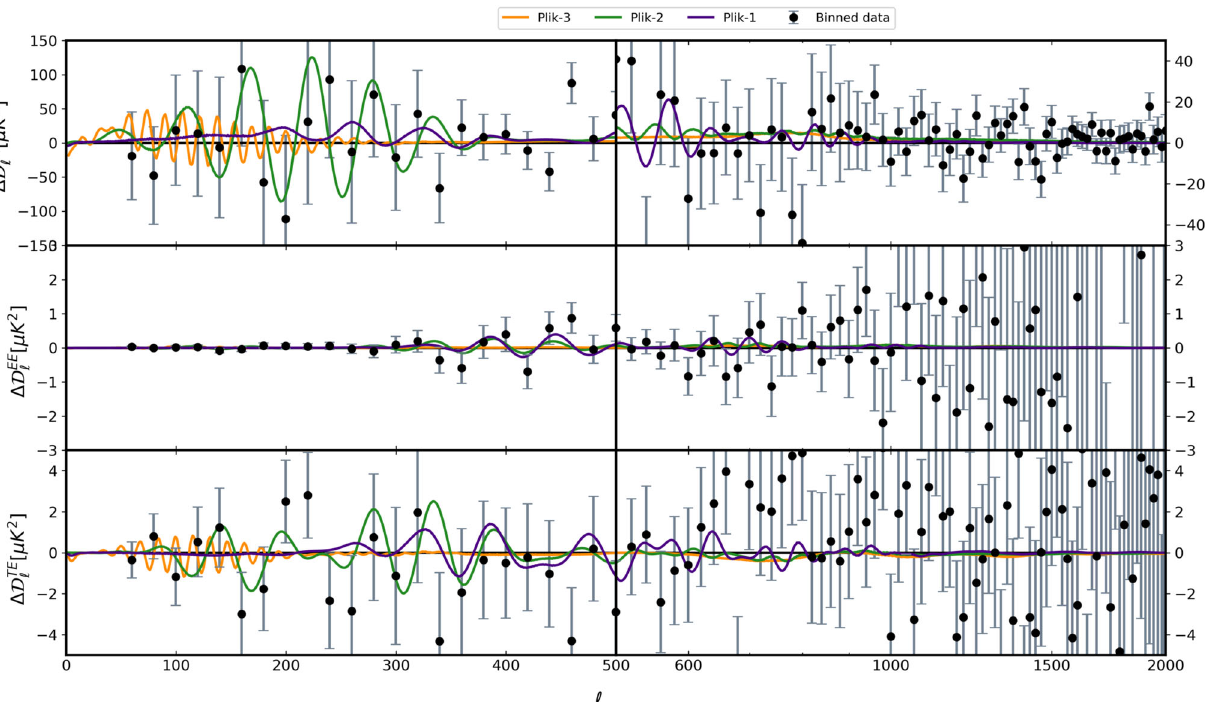
Fig. 4 Residual plots corresponding best-fit candidates to Plik-bin1 TTTEEE + lowT + lowE likelihood. Here residual is calculated from the power-law (cid:2) CDM model. Zero line corresponds to the power-law (cid:2) CDM model and data points are from the 2018 Planck Plik data residual to the power law best